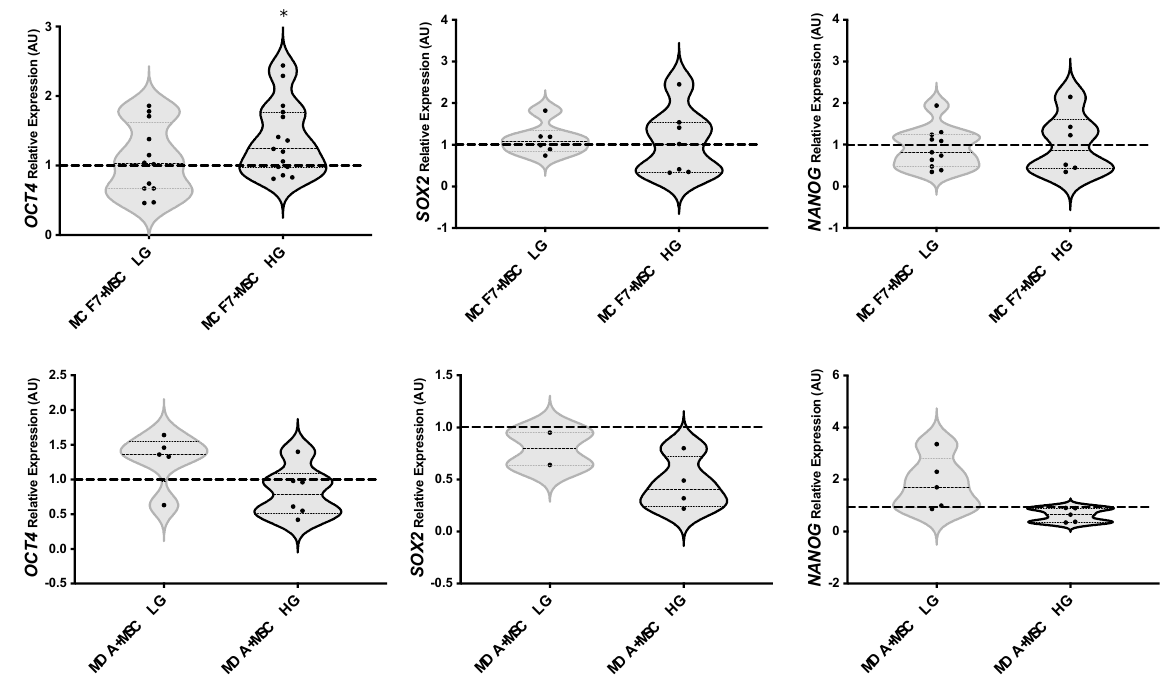
Figure 4. Effect of glucose on BC cells stemness in 2D cultures with MAT-MSCs. ( a ) MCF7 or ( b ) MDA-MB231 were co-cultured-and not—with MAT-MSCs in low glucose (5.5 mM; LG) or standard/high glucose (25 mM; HG) medium. After 72 h, mRNA expression levels of stemness genes ( OCT4, SOX2, NANOG ) were determined by qPCR (see Methods and Supplementary Table S1). Data were normalized on PPIA gene as internal standard. Results were represented as violin plot of 7 – 15 independent triplicate experiments showing mRNA levels of OCT4, SOX2 and NANOG in ( a ) MCF7 + MSC LG/HG and ( b ) MDA-MB231 + MSC LG/HG as relative expression (2 − Ct ) compared to that in monocultured cells (MCF7/MDA-MB231 LG/HG; dotted line). Data were analyzed using the non-parametric Wilcoxon test for pairwise comparisons. * denotes statistically significant values (* pval < 0.05).